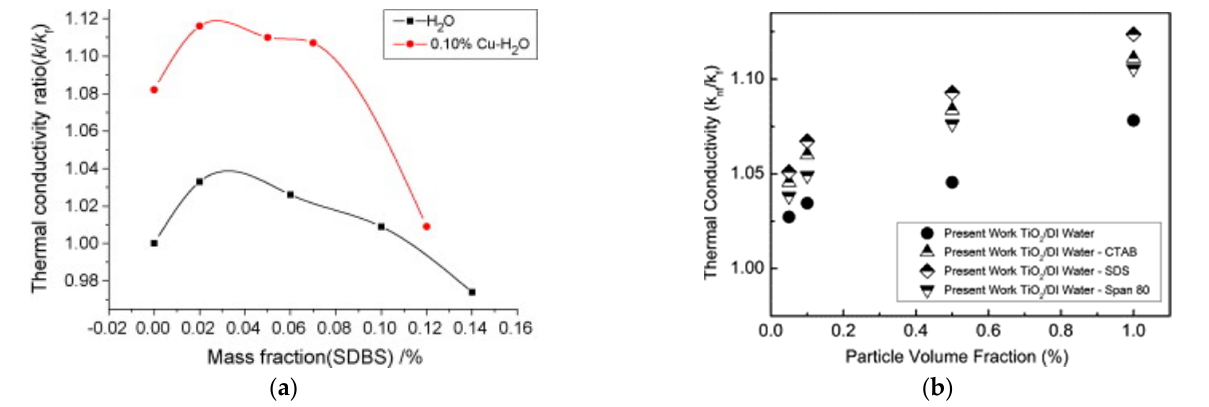
Figure 6. Effect of ( a ) surfactant concentration [29] and ( b ) type of surfactant [48] on thermal conductivity.